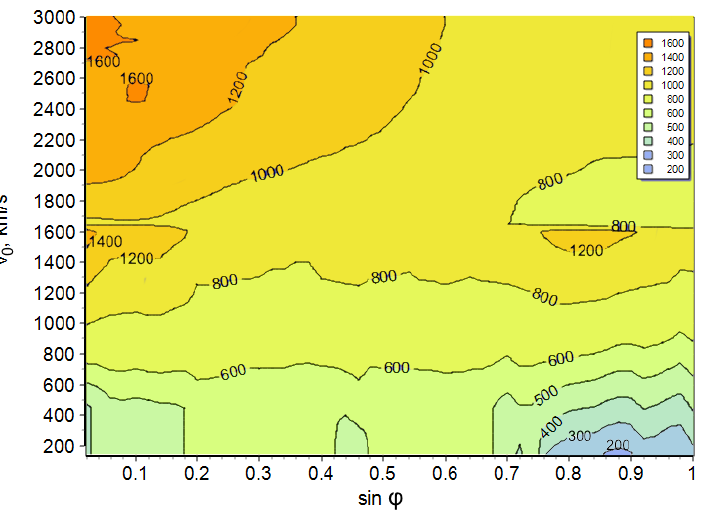
Figure 5. The relation of the expected ICME transit speed to the initial CME speed and the sine of the associated flare absolute heliolongitude. Different colors indicate the gradation of the expected transit speed in